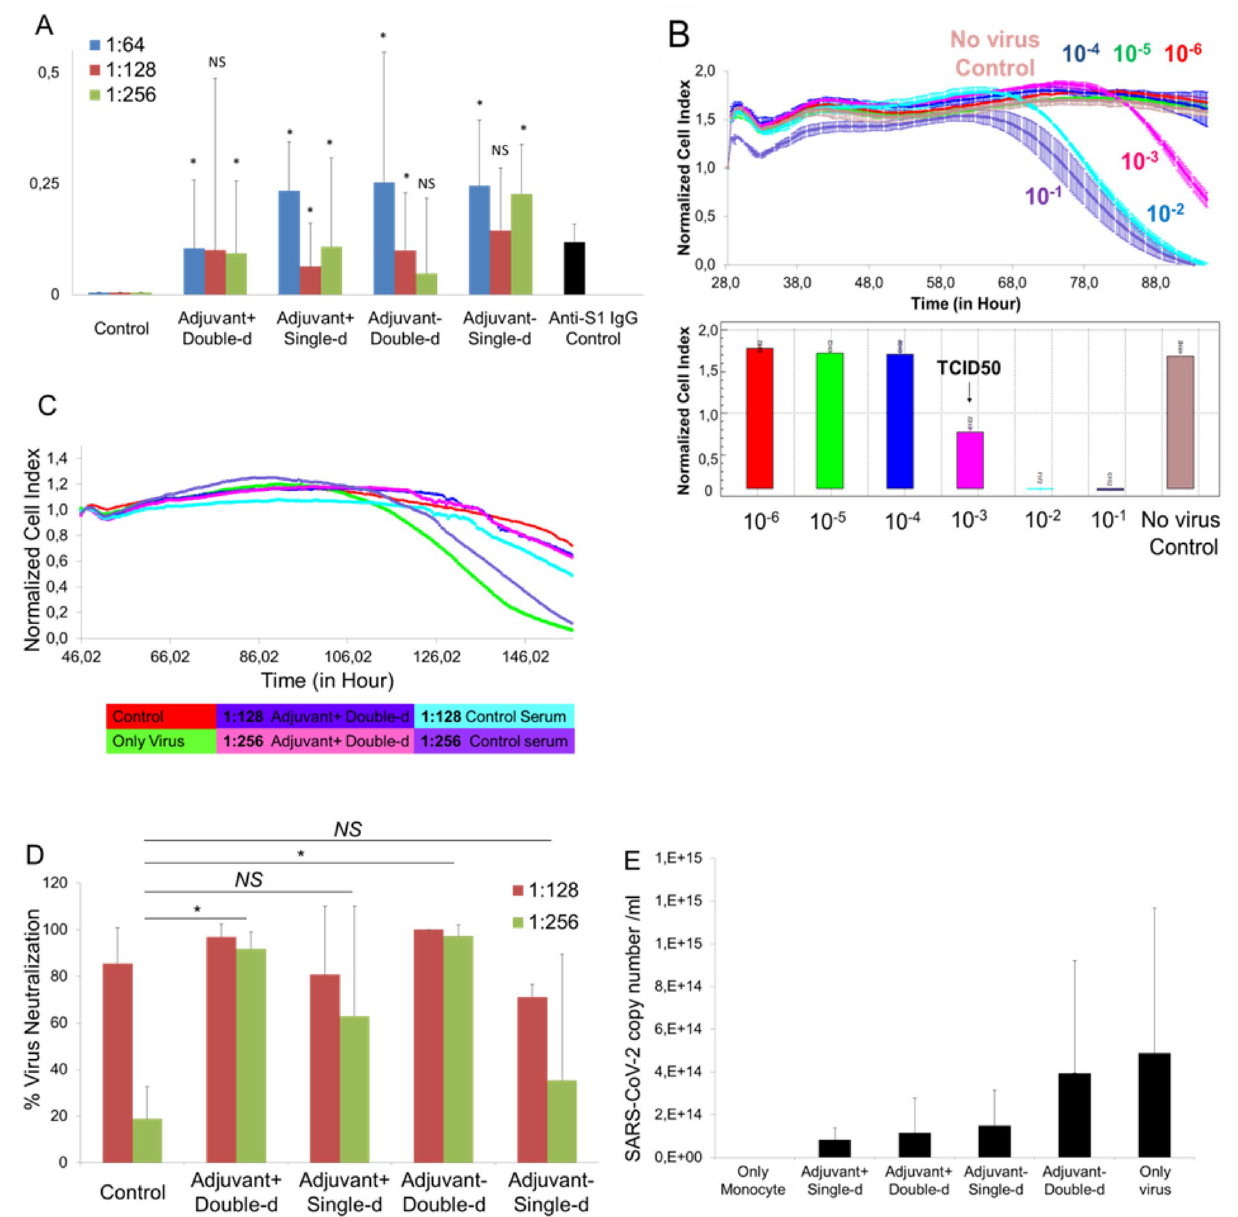
Figure 7. Pre-clinical efficacy study of vaccine candidates, SK-01 V1, and OZG-3861 V1. ( A ) Bar graph showing SARS-CoV-2 specific IgG analysis of the groups concerning the positive control antibody, mouse SARS-CoV-2 Spike S1 monoclonal antibody using ELISA. ( B ) Upper graph showing RTCA analysis of infective active SARS-CoV-2 in a dose-dependent manner for 6 days. Bar graph showing quantified normalized cell index values of SARS-CoV-2 titrations to determine TCID50 dose. ( C ) Representative RTCA graph of neutralization assay in which 1:128 and 1:256 dilutions of adjuvant positive double-dose (SK-01 V1) and control mice serum preincubated with 100 × TCID50 dose of SARS-CoV-2. ( D ) Bar graph showing quantified virus neutralization ratio of the vaccine treated groups at 1:128 and 1:256 dilutions. ( E ) Bar graph showing quantitated SARS- CoV-2 copy numbers when culturing on healthy adult monocytes along with 1:256 mice serum to determine Antibody-Dependent Enhancement (ADE). The threshold of significance for all tests was set at * p < 0.05. NS is